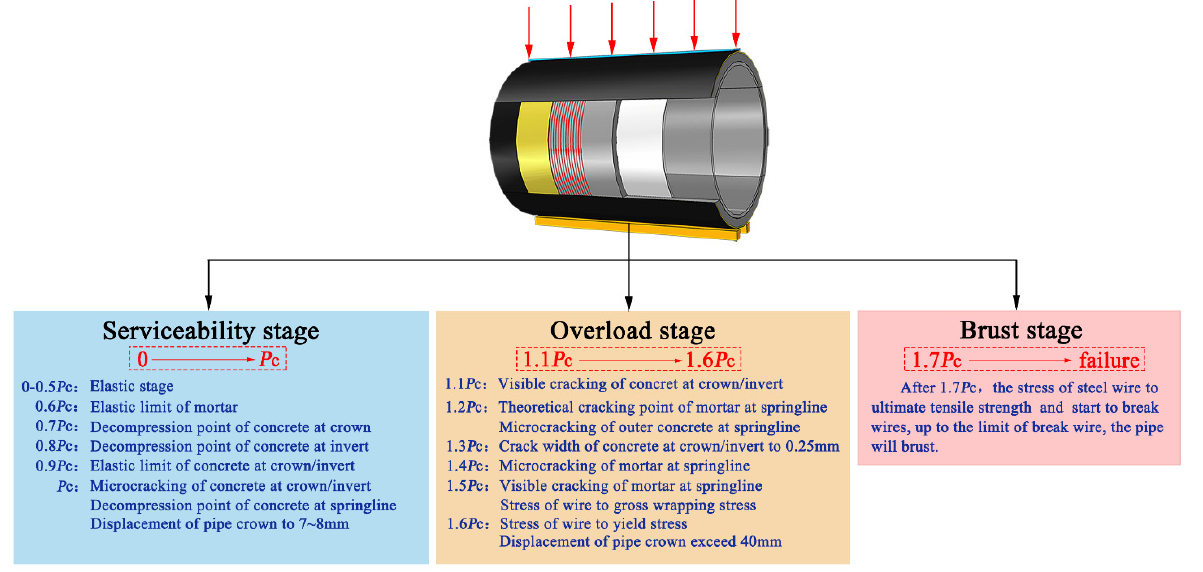
Figure 16. Schematic diagram of PCCP mechanical response.